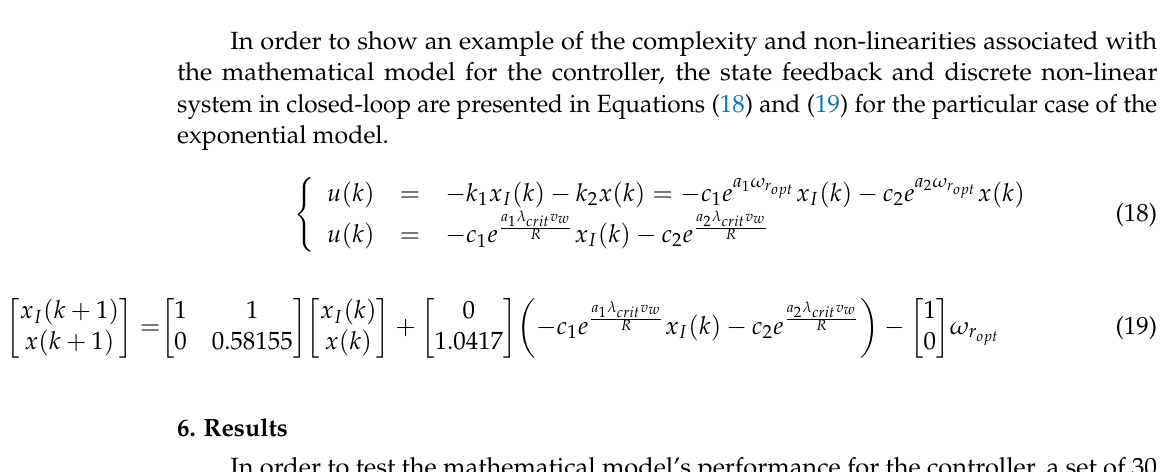
Figure 6. Graphics related to the functions for calculating the state variable